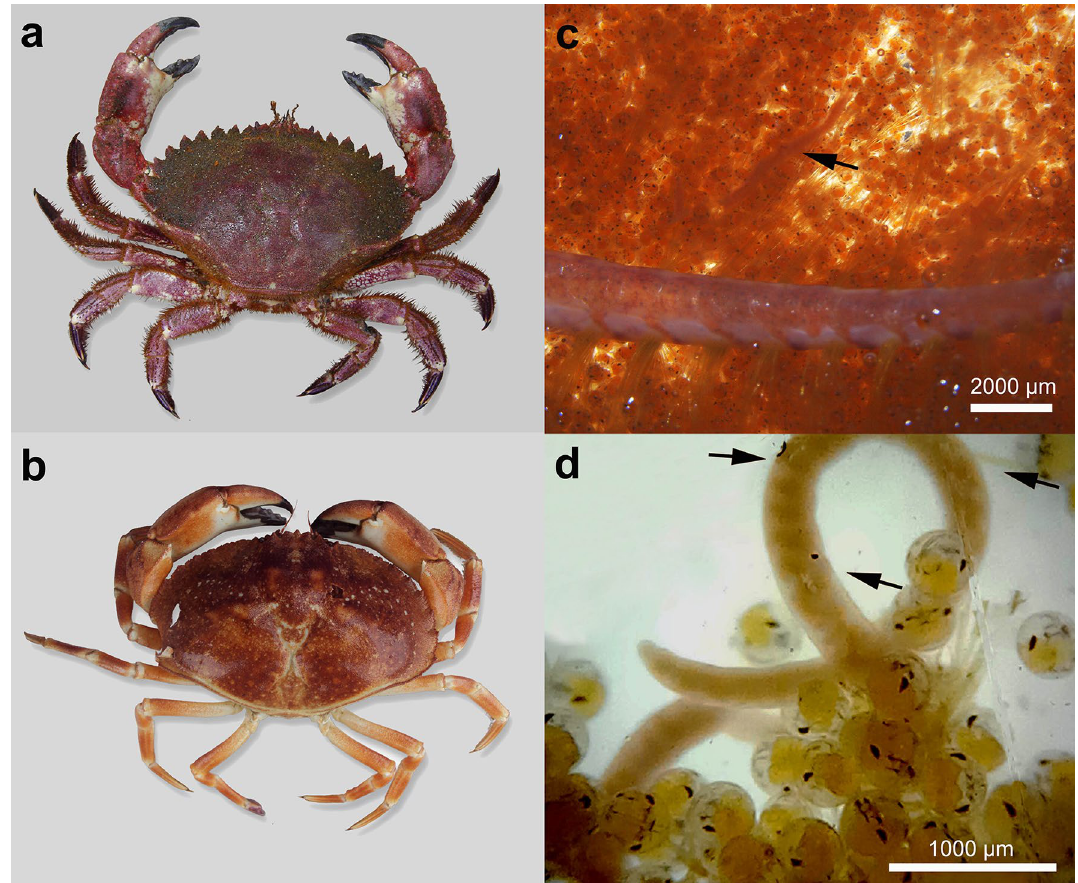
Figure 1. Host crab species Romaleon setosum ( a ) and Cancer porteri ( b ) infected by Carcinonemertes camanchaco sp. nov . present in their egg masses ( c , d ).